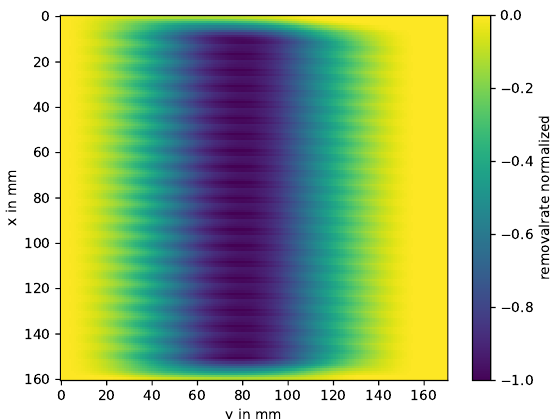
Figure 4. Simulated removal generated by the virtual TIF on the calculated tool